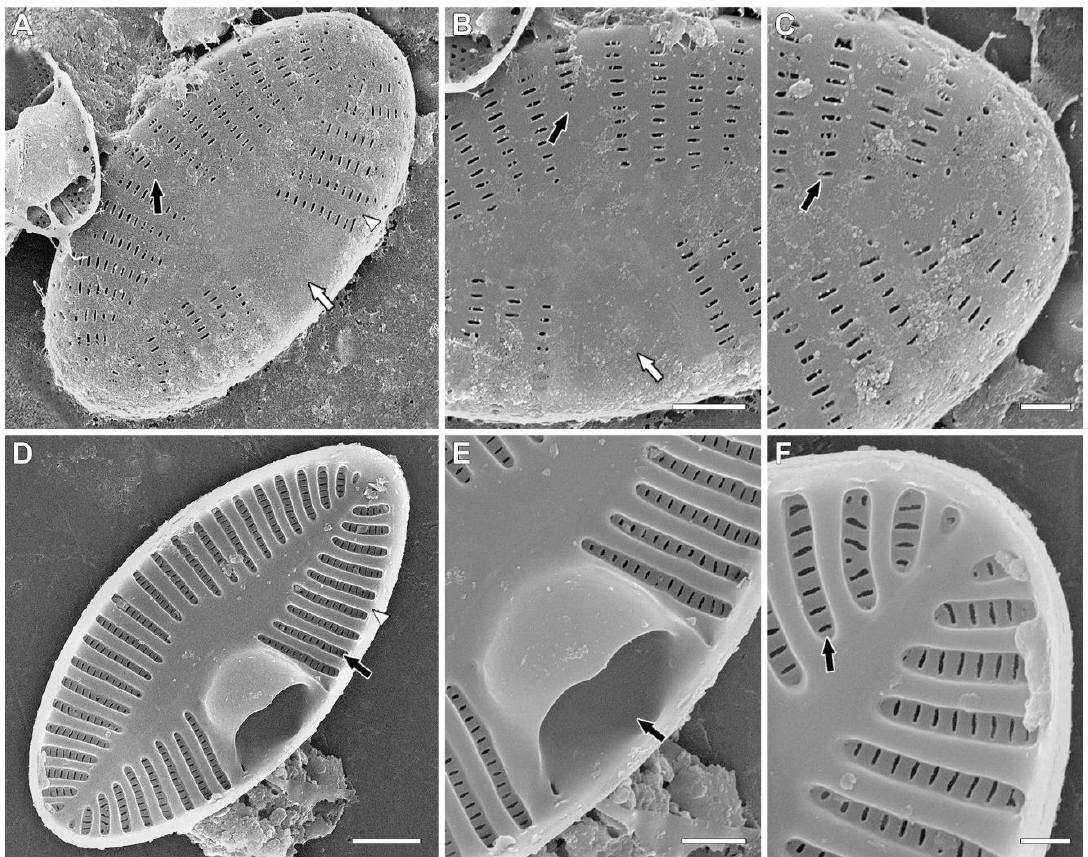
Figure 3. Planoplatessa joursacensis (Héribaud) Kulikovskiy, Glushchenko & Kociolek comb. nov. Scanning electron microscopy. Rapheless valves. ( A ). The entire valve, external view. Black arrow shows the shortened central stria. White arrow shows the central area. White arrowhead shows the interstria. ( B ). Central area, external view. Black arrow shows the shortened central stria. White arrow shows the central area. ( C ). Valve end, external view. Black arrow shows the uniseriate stria. Black ( D ). The whole valve, internal view. Black arrow shows the uniseriate stria, situated in deep alveola. White arrowhead shows the interstria. ( E ). Internal view. Black arrow shows the cavum. ( F ). Valve end, internal views. Black arrow shows the uniseriate stria, situated in deep alveola. Scale bar ( A, D ) = 2 μm; ( B, E ) = 1 μm; ( C, F ) = 0.5 μm. Externally, central area large and flat on one side of valve (Figure 3A,B, white arrows); in another part, all striae are normally present or one central stria is slightly shorter (Figure 3A,B, black arrows). Internally, a large cavum is present (Figure 3E, black arrow). Striae are situated in deep alveoli (Figure 3D, F, black arrows).